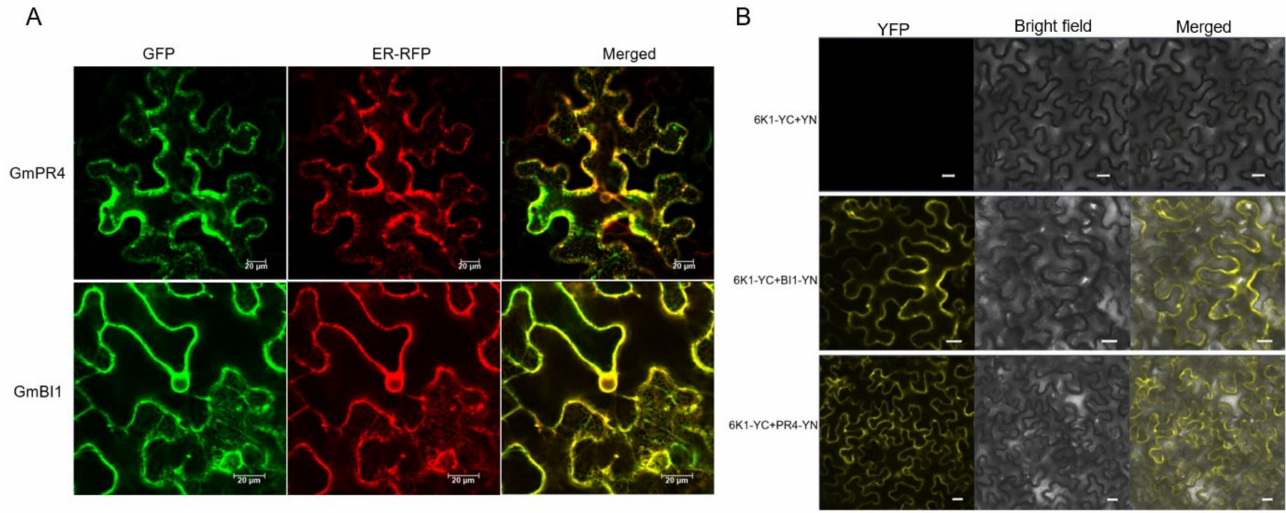
Figure 5. Subcellular localization of GmPR4/GmBI1 and analysis of interactions between 6K1 and PR4/BI1 by BiFC assay. ( A ) Subcellular localization of PR4 and BI1 in N.benthamiana leaf epidermis cells. ( B ) Verifying the interactions between 6K1 and PR4/BI1 by BiFC assay. PR4/BI1-YN and 6K1-YC were co-agroinfiltrated into leaves of one-month-old N. benthamiana . Interaction between 6K1-YC and YN was used as the negative control. Scale bars = 20 µ